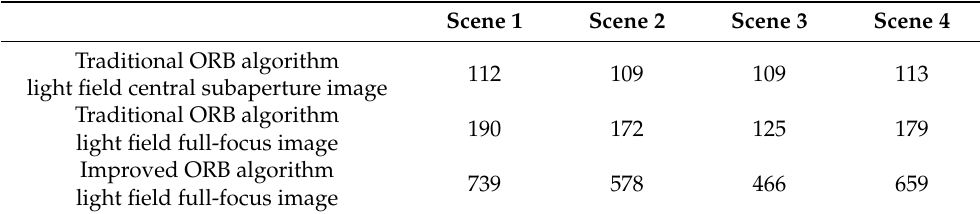
Table 2. Number of matching pairs of image feature